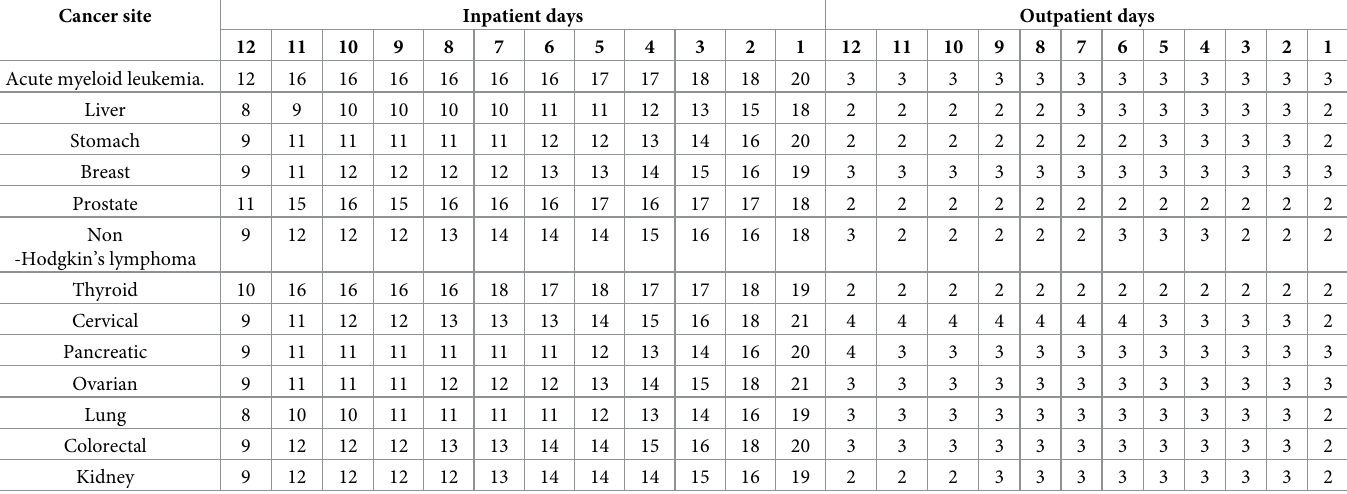
Table 2. Number of inpatient and outpatient days per patient with cancer by month in the last year of life. Cancer